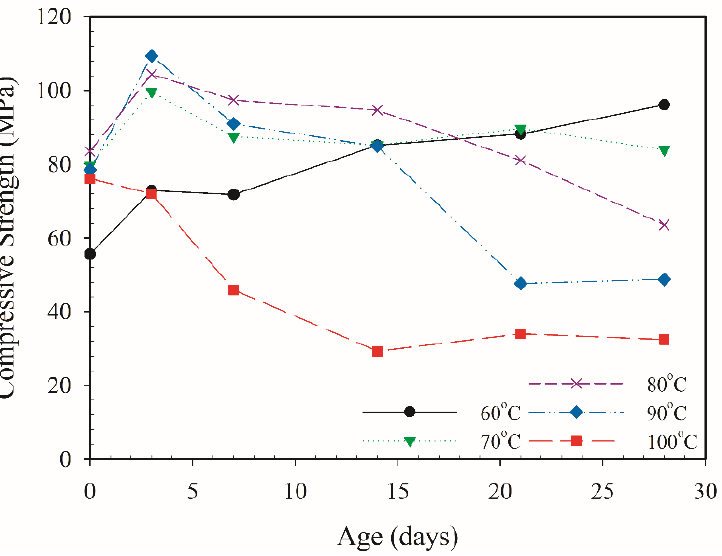
Figure 10. Changes in compressive strength with standing time in air under various curing tem- peratures after 24-h curing when AE% = 6%.